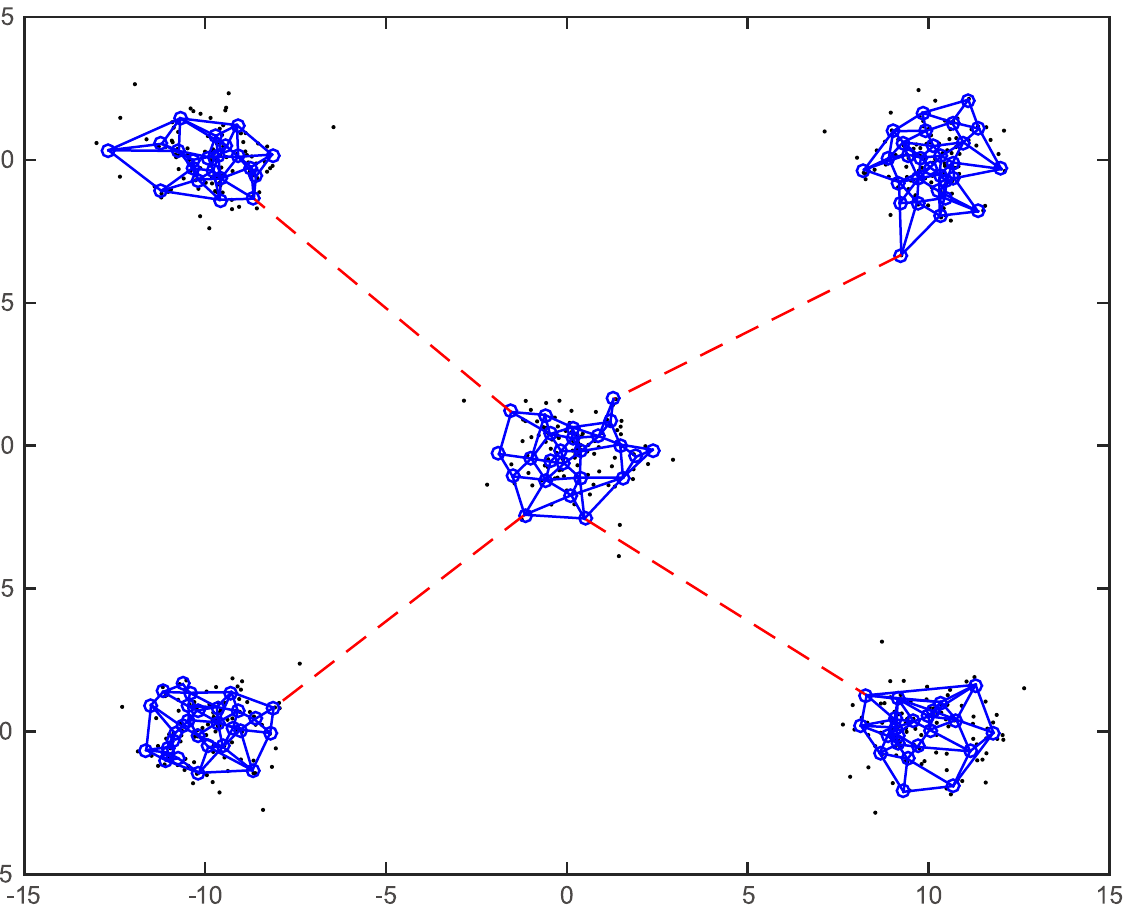
Fig 2. Connecting the subgraphs in ITRN step 10. The dataset is formed of randomly generated nodes comprising five non-overlapping clusters (S1 Dataset). Black dots indicate the training patterns (500 nodes), and blue circles indicate the codebook vectors (100 vectors). In addition, the blue solid lines are established by ITRN steps 1 – 9 and the dotted lines are established by ITRN step